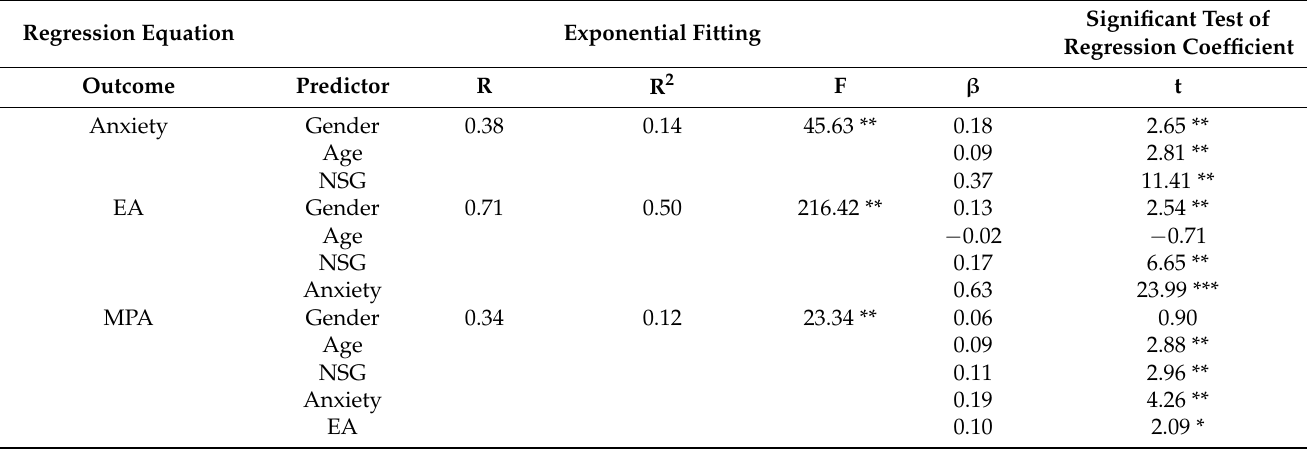
Table 2. Regression analysis of variable relationships in the mediation